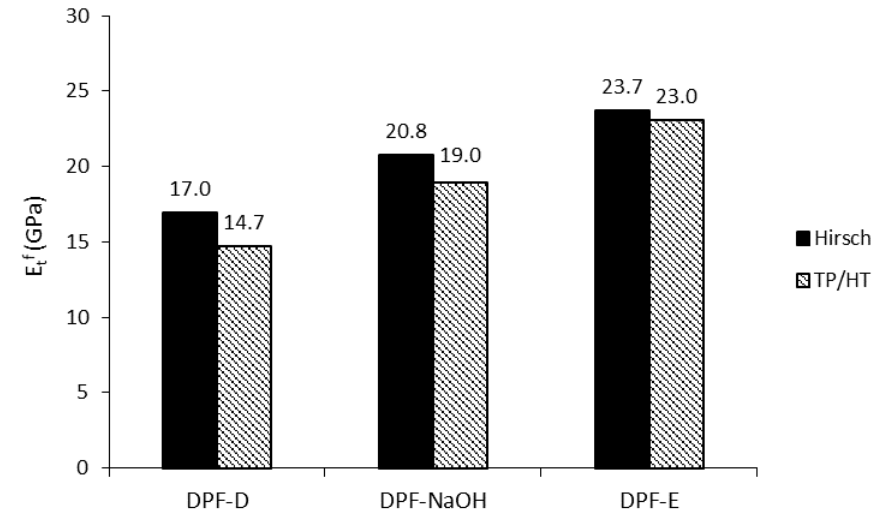
Figure 8. Intrinsic Young’s modulus of date palm fibers computed via Hirsch and TP/HT.